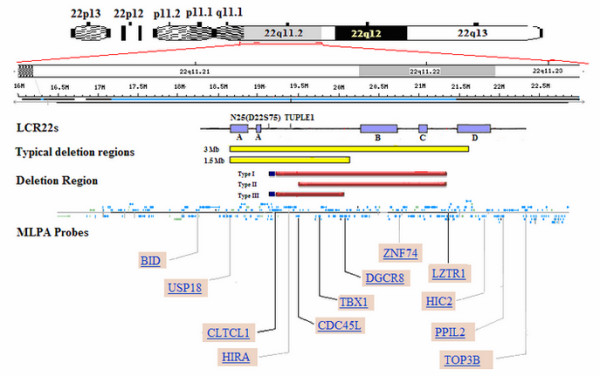
Genomic map of the 22q11.2 region based on human genome overview page (Build 37.1). The relative positions of LCR22s and ranges of LCR22-A, -B, -C, and -D, as defined by Shaikh et al. [5], are depicted. The FISH probes N25 (D22S75) and TUPLE1 are marked on the LCR22s. The 3 Mb and 1.5 Mb typical deletion regions are shown in yellow. The MLPA probes were arranged according to the manufacturer's product information (MRC-Holland) and the position of the related gene in chromosome 22q11.2. The three types of deletion regions are delineated as Type I, Type II, and Type III, corresponding to the N25(D22S75) to LZTR1, CDC45L to LZTR1, and N25(D22S75) to LZTR1, respectively. The red lines indicate the deletion regions detected by MLPA analysis, whereas the blue lines designate the results of the FISH analysis.